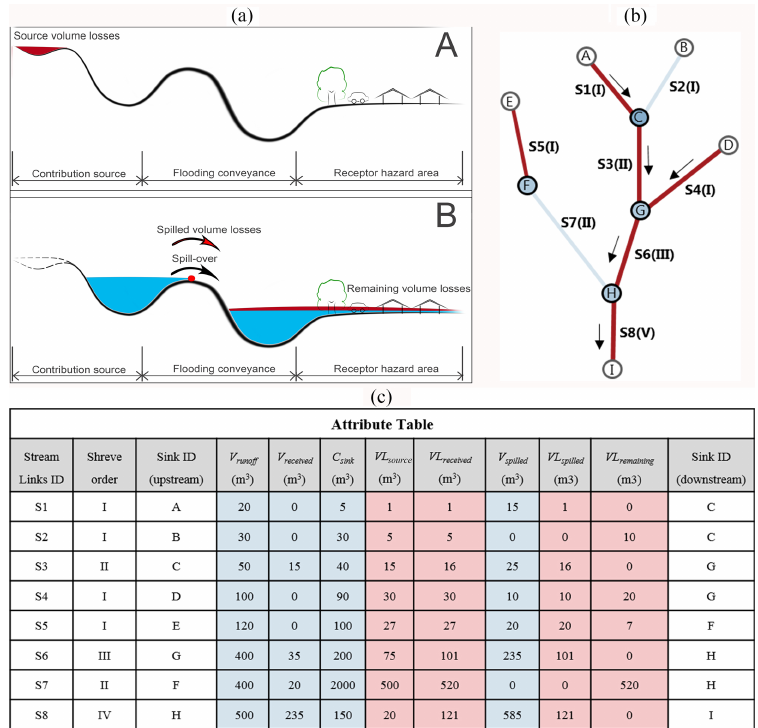
Figure A3. ( a ) The generation of source volume losses due to removed sinks (A) and the redistribution of volume losses (B). ( b ) Network geometry features, where Points A–I illustrate sinks, and blue points represent the sinks that contain VL remaining . Edges S1–S8 stand for stream links and red edges represent the stream links that contain VL spilled . ( c ) Attribute table containing the computational information corresponding to the geometry features, where blue zones represent link-based fast- inundation spreading computations, and red zones represent volume losses spreading